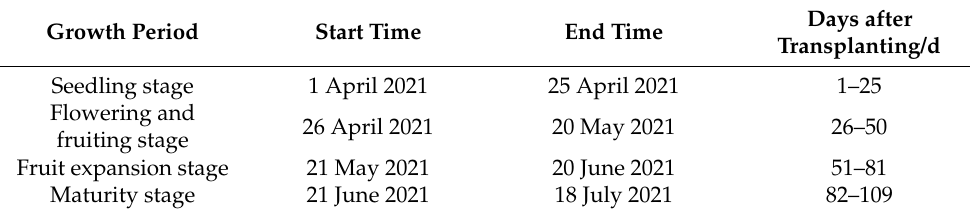
Table 3. Pepper growth